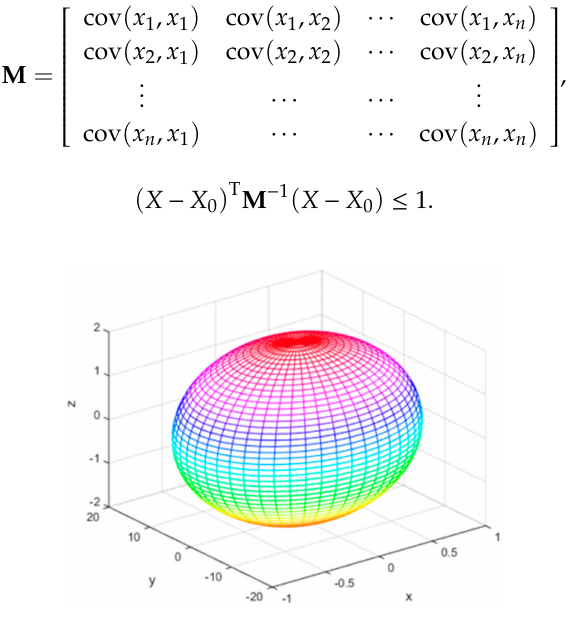
Figure 7. Three-dimensional interaction